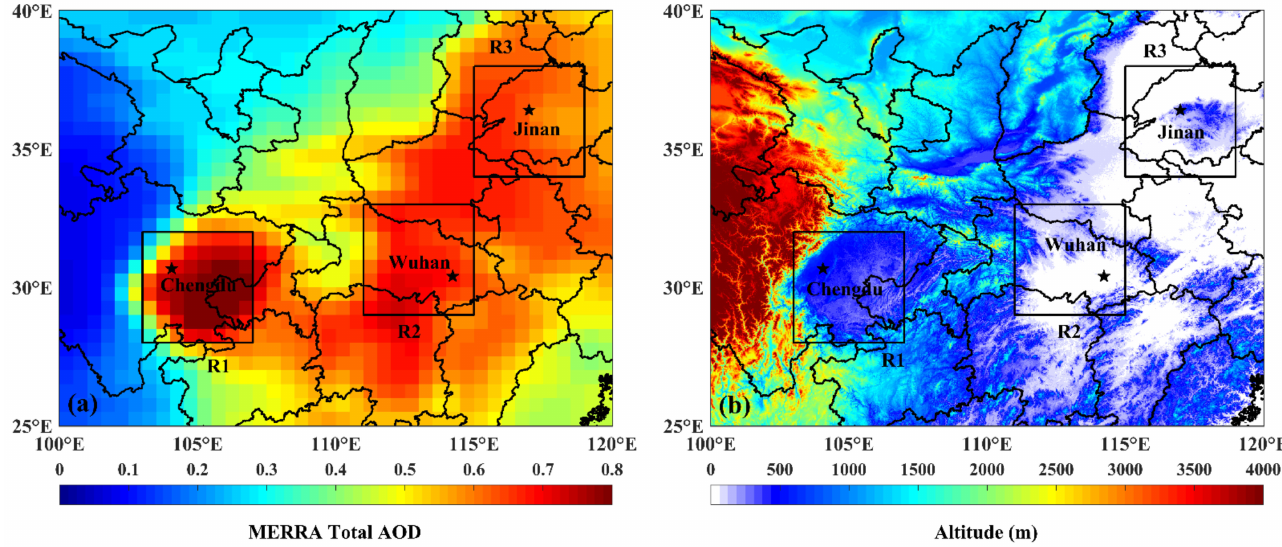
Figure 2. ( a ) Spatial distribution of total AOD during 2010–2018 with a spatial resolution of 0.5 ◦ × 0.5 ◦ . The regions of interest in this study are marked with black rectangles, and the major cities in each study region are marked with black asterisks. ( b ) The map of terrain (unit: m). All AOD data are derived from the MERRA-2 data